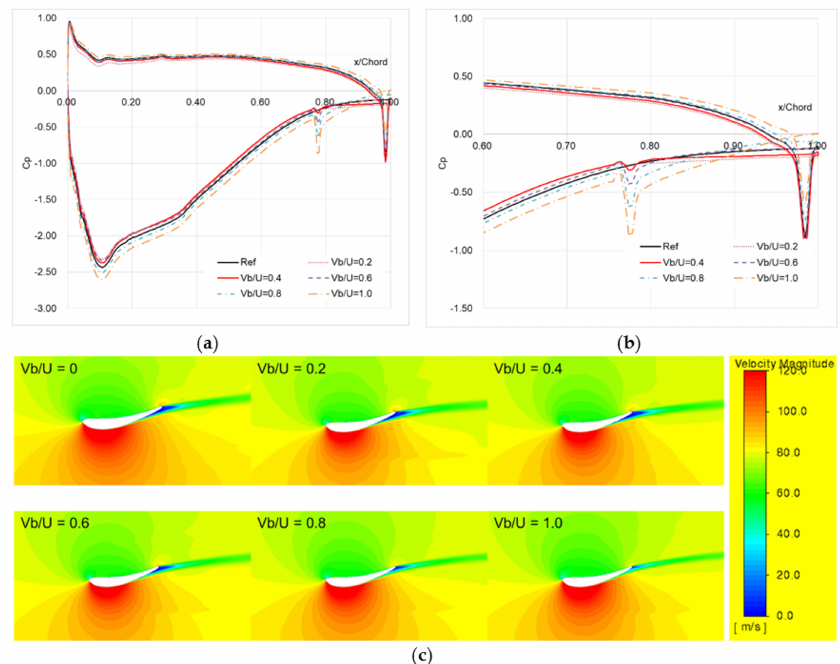
Figure 11. Comparison of flow patterns for di ff erent discharge velocities when the discharge position is 0.75C and the discharge is tangential to the vehicle driving direction; ( a ) Surface pressure distribution; ( b ) Zoomed view of surface pressure distribution around the trailing edge; ( c ) Velocity magnitude scale from 0 m / s to 120 m / s.